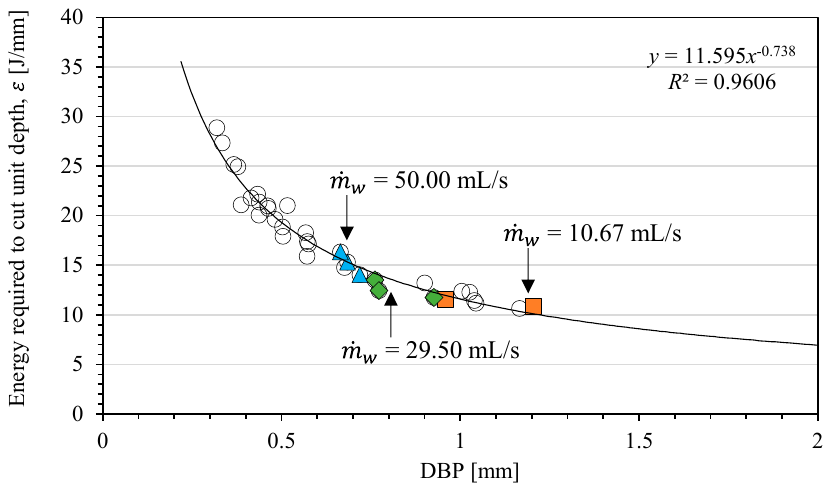
Figure 11. Energy required to cut a unit depth versus DBP.